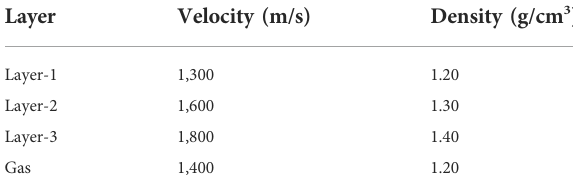
TABLE 2 Geological parameters of the fault